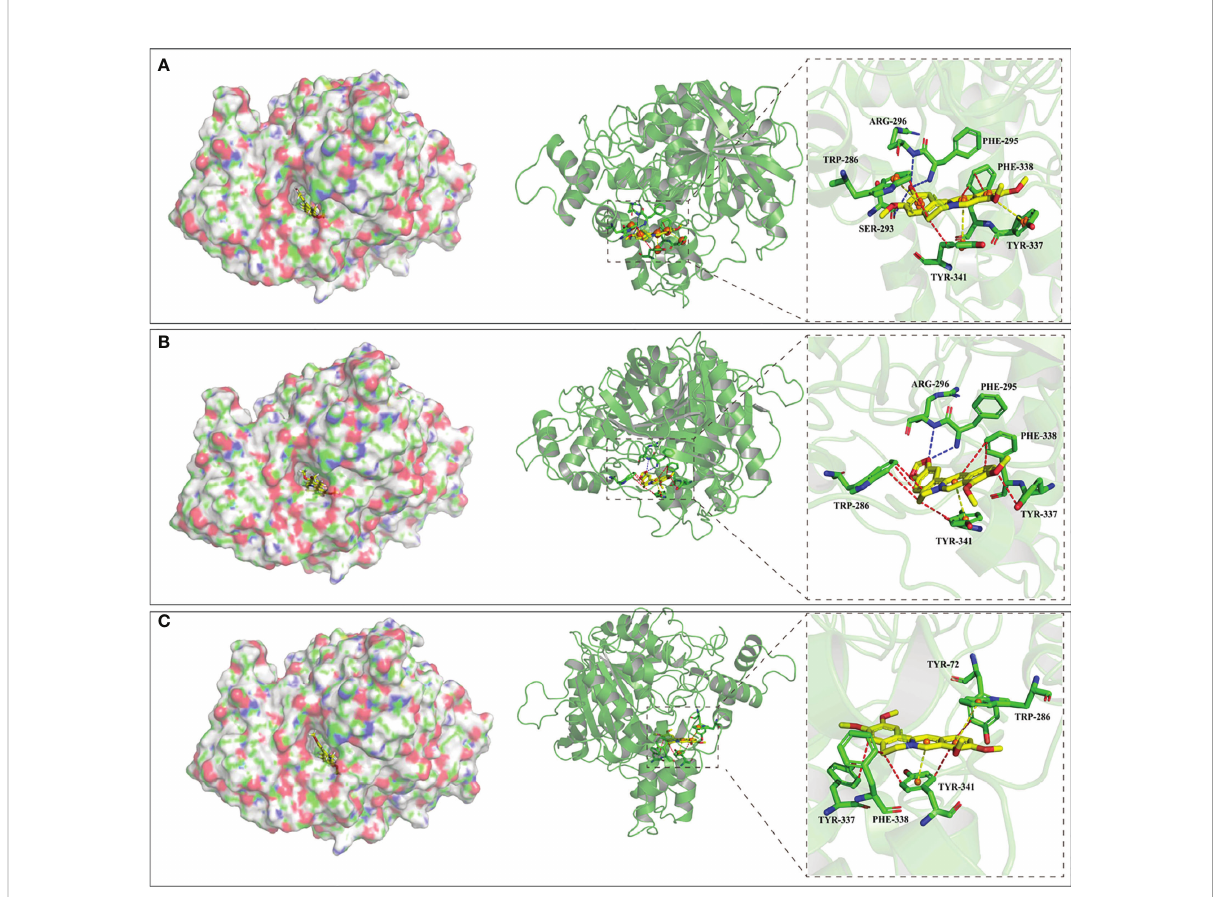
FIGURE 6 The visualization of molecular docking results. The letters of (A – C) represent the visualization result columbamine, berberine and palmatine, respectively. The left parts exhibit these compounds interact with AChE at a long andnarrow hydrophobic pockets, and the rights parts exhibit the detail of these interactions. Red, blue and yellow lines represent hydrophobic interaction, hydrogen bond and - stacking interaction,